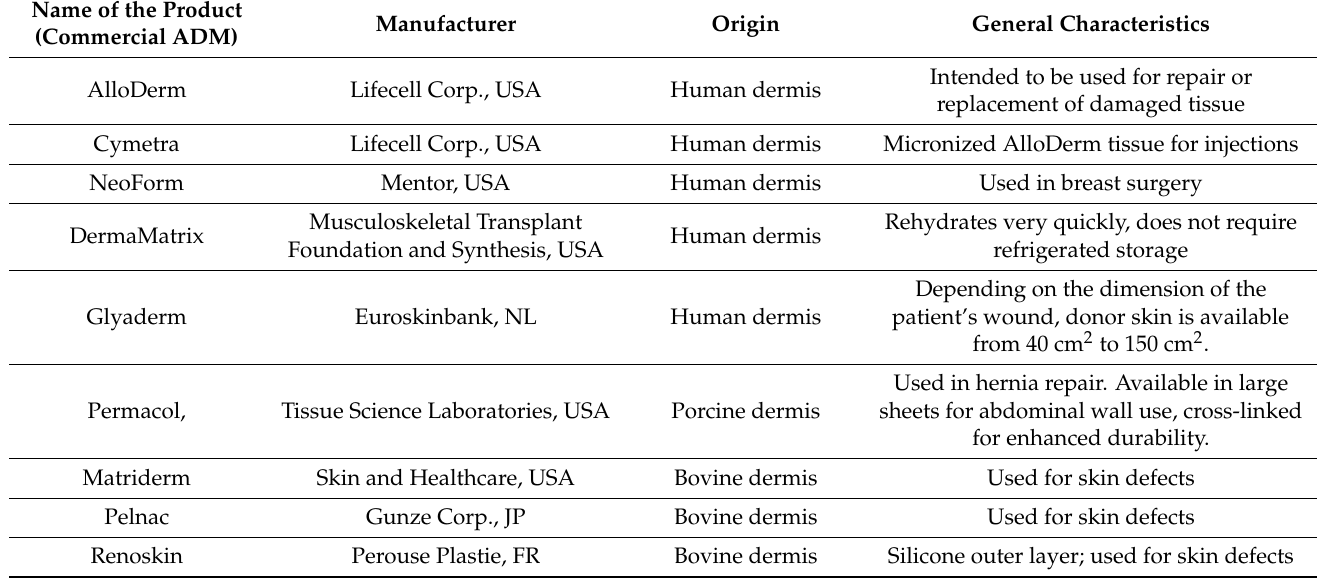
Table 1. Examples of commercial ADM products available on the market. (ADM—acellular dermal